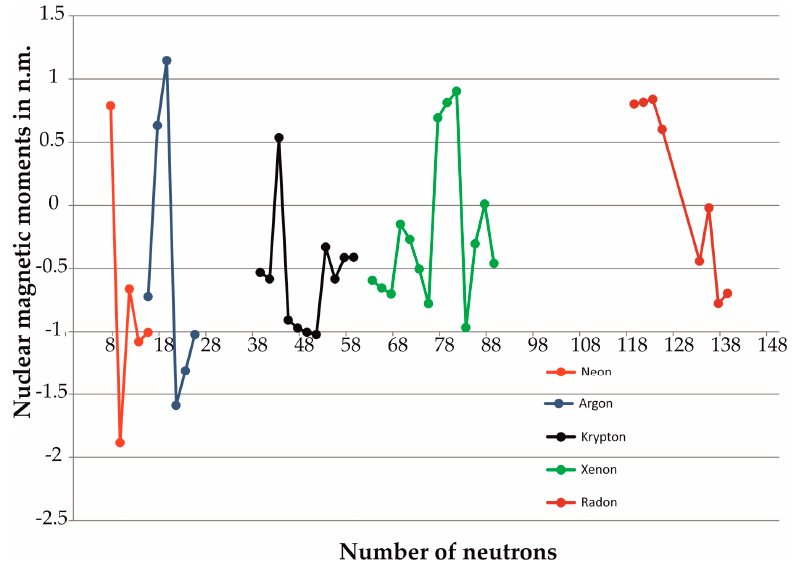
Figure 5 Figure 5. The nuclear magnetic moments plotted versus the number of neutrons in the